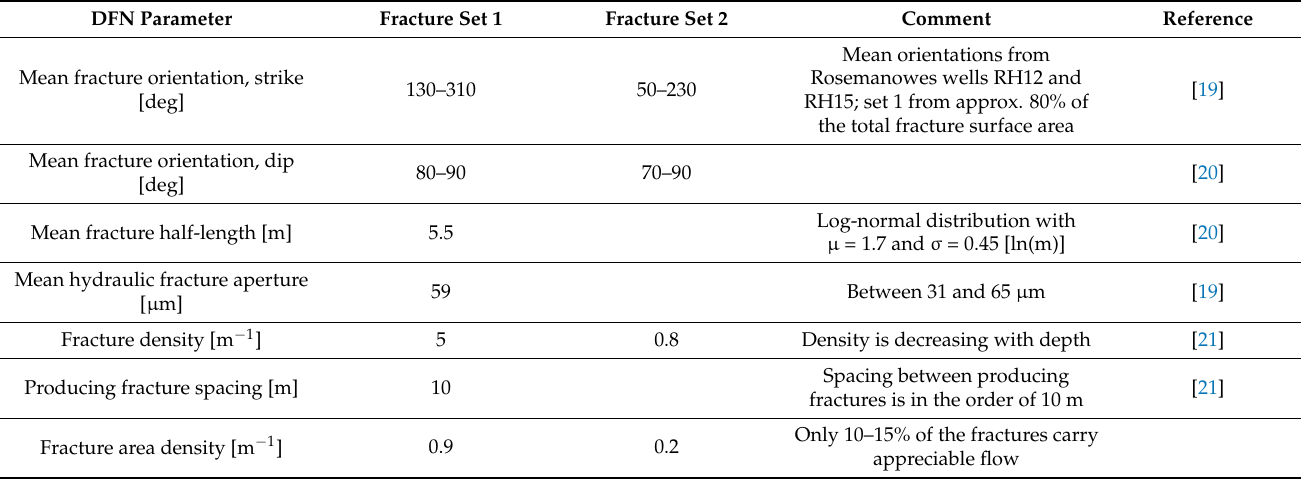
Table 1. DFN characteristics of host rock